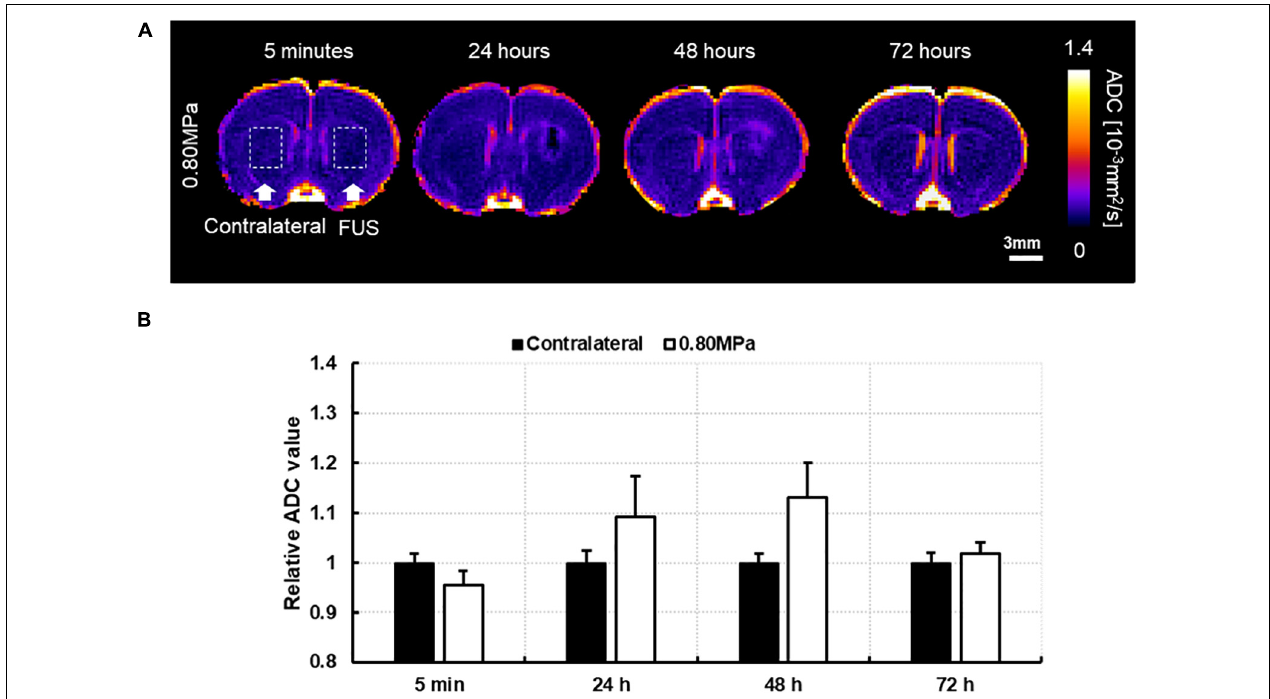
FIGURE 5 | (A) A representative image of follow-up ADC at 5 min, 24, 48, and 72 h after 0.80 MPa sonication at caudate putamen. (B) The ADC signals in ROI are analyzed in sonication and contralateral